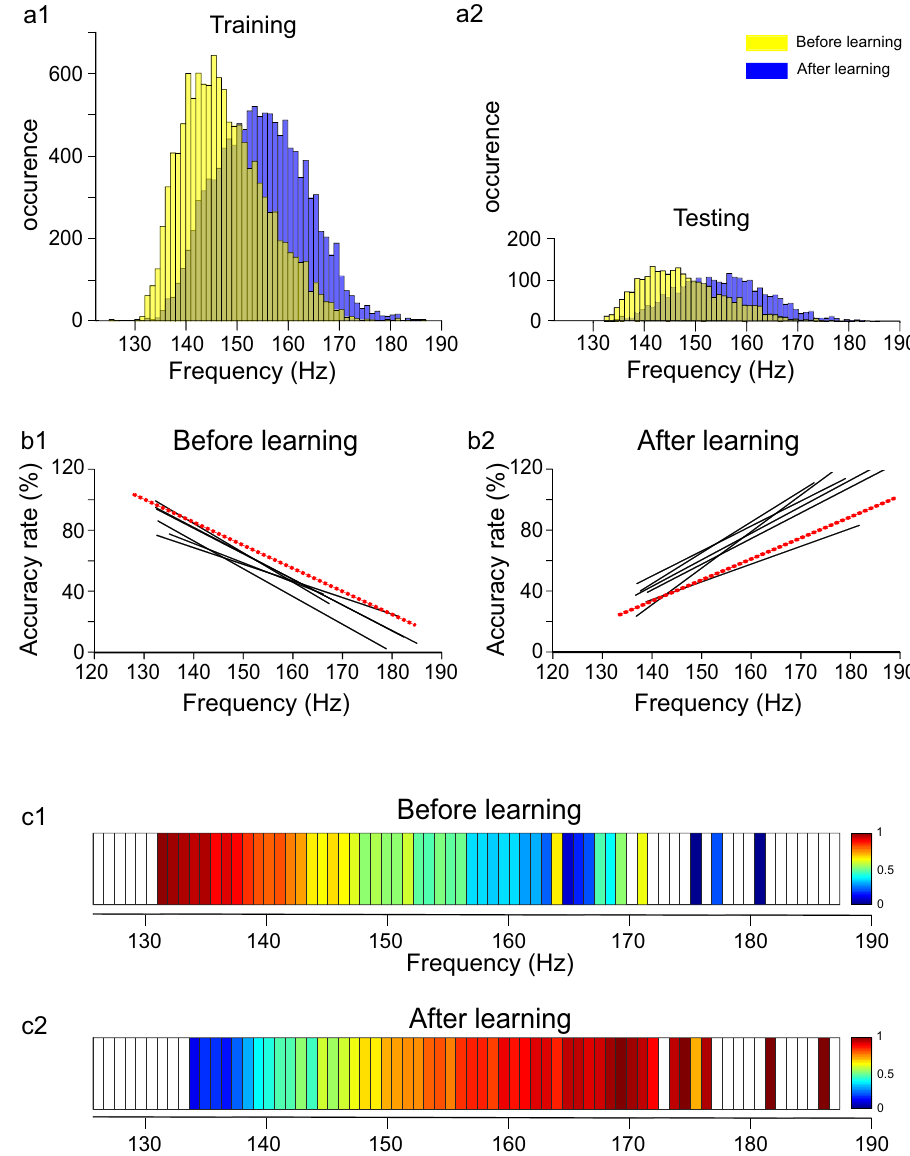
Figure 3. Accuracy rate of RCIs is correlated with the intrinsic frequency of SWRs in the WT mice. The post-learning increase of SWRs’ frequency was present both in the training ( a1 ) and the testing pools of RCIs ( a2 ). AR was correlated with SWRs’ frequency in individual animals ( b1–2 ) as well as in the pooled set of RCIs ( c1–2 ). Notice a positive correlation between SWR’s frequency and AR of RCI belonging to "after" learning (see regressions lines in b2, color bars in c2 ) and a reverse relationship that was expressed "before" learning (see regressions lines in b1, color bars in c1 ). Regression lines indicated in black—correspond to individual animals, in red—to pooled RCIs. Color code is expressed in the percentage of AR ( c1–2